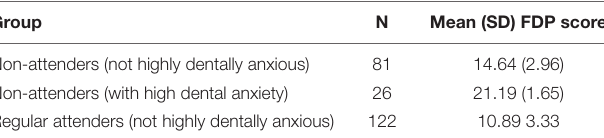
TABLE 3 | Fear of dental pain (FDP) scores in relation to dental anxiety and attendance. Group